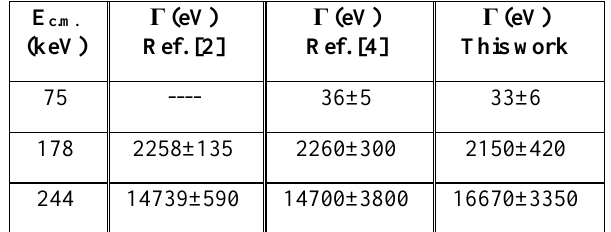
Table 1 - Total level width available in literature compared with the present